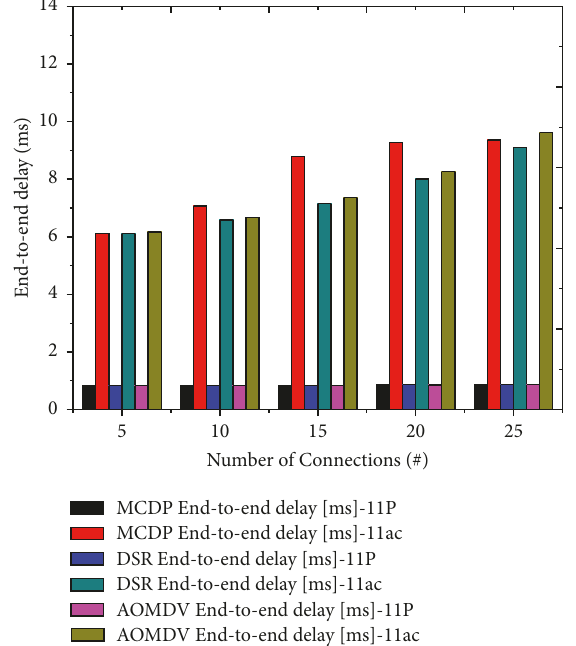
Figure 9: End-to-end delay comparison of MCDP, DSR, and AOMDVprotocolsover802.11Pand802.11acwithdifferentnumbers of connections.